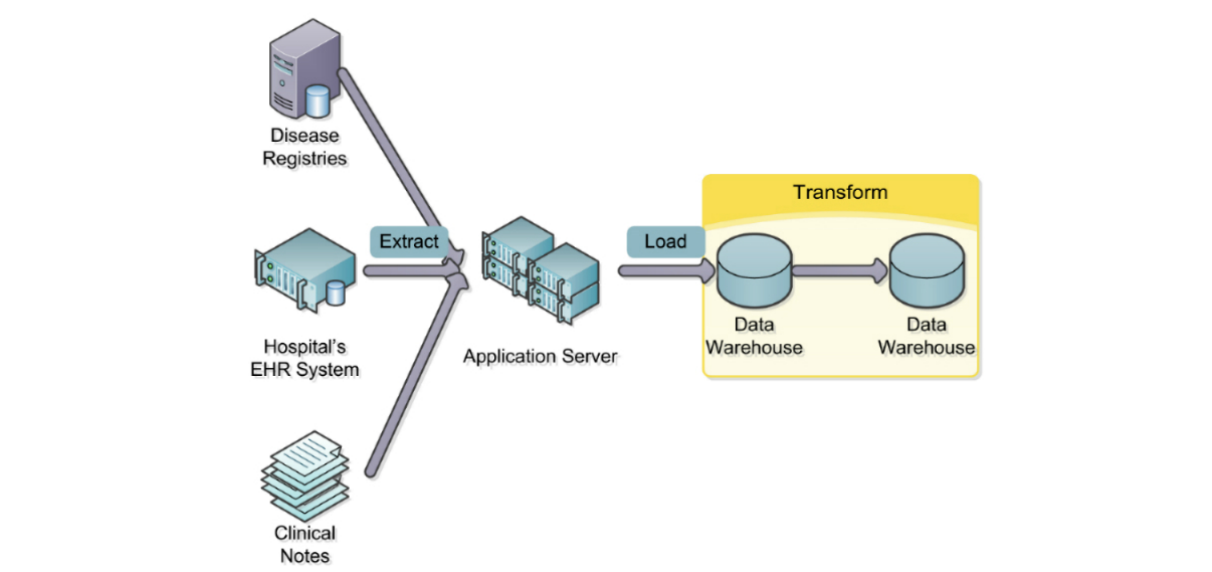
Figure 2. An overview of the extract, load, and transform (ELT) process. Data is extracted from multiple sources including disease registries, hospital’s EHR system, and clinical notes.